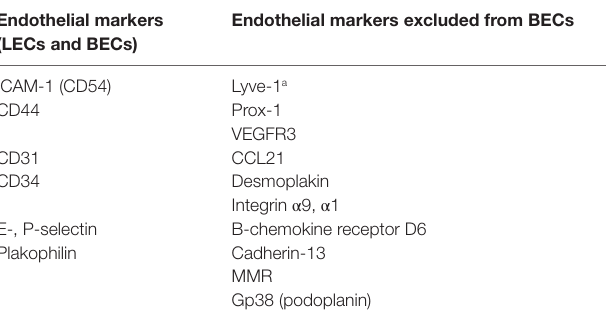
TABLe 1 | Summary of surface markers for identifying murine and human lymphatic endothelial cells. endothelial markers (LeCs and